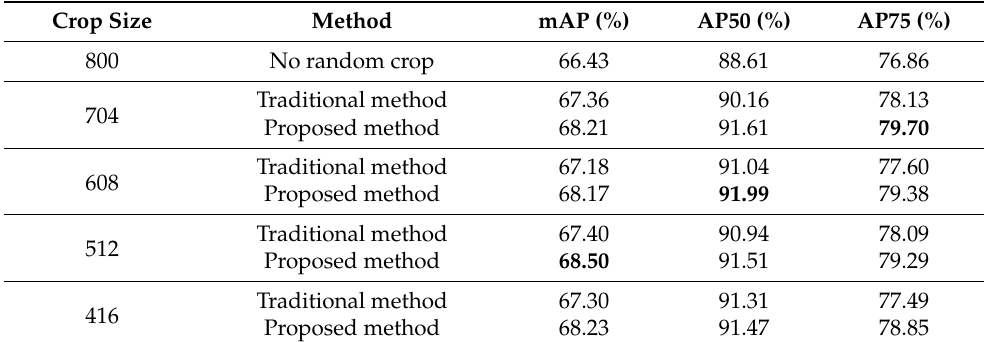
Table 3. Test results of different configurations. Bold values refer to the best one.